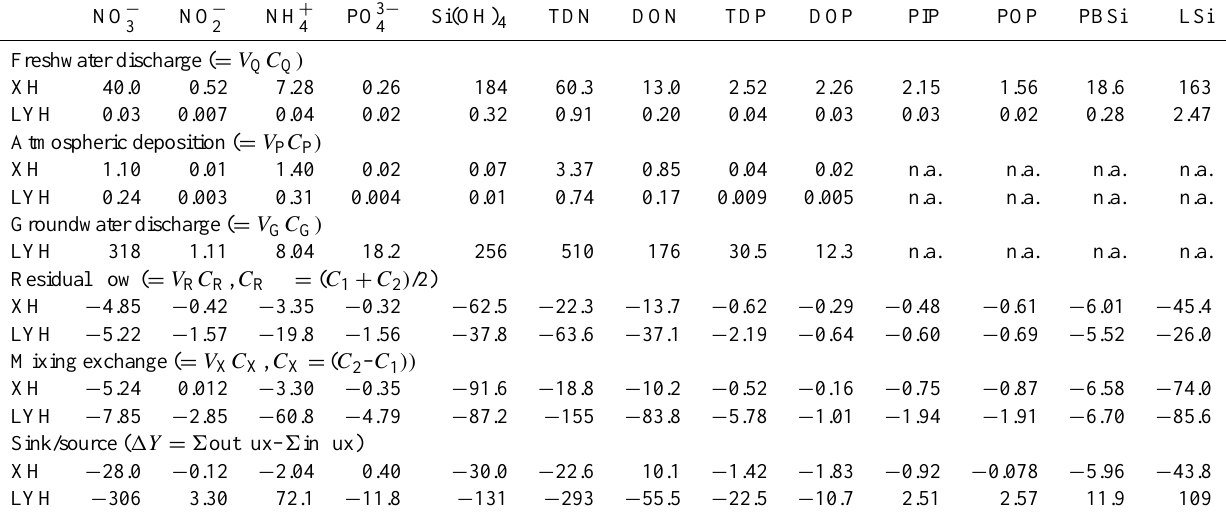
Table 4. Nutrient budgets (10 6 molyr − 1 ) in Xiaohai (XH) and Laoyehai (LYH) lagoons. C 1 and C 2 are the average nutrient concentrations in the system of interest and the adjacent system, respectively. V R C R ,V X C X and 1 are the residual nutrient transport out of the system of interest, the mixing exchange flux of nutrients, and the non-conservative flux of nutrients, respectively. Negative and positive signs of 1 indicate that the system is a sink or a source, respectively.